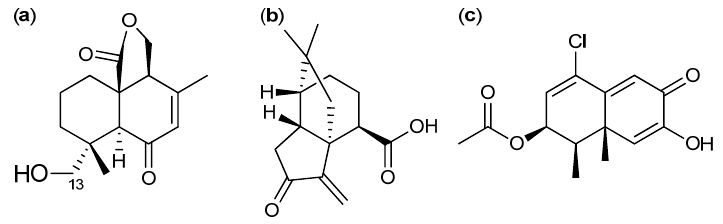
Figure 18. ( a ) Fudecadione A, ( b ) Terrecyclic acid A and ( c ) a novel unnamed chloro-trinoreremophilane sesquiterpene.